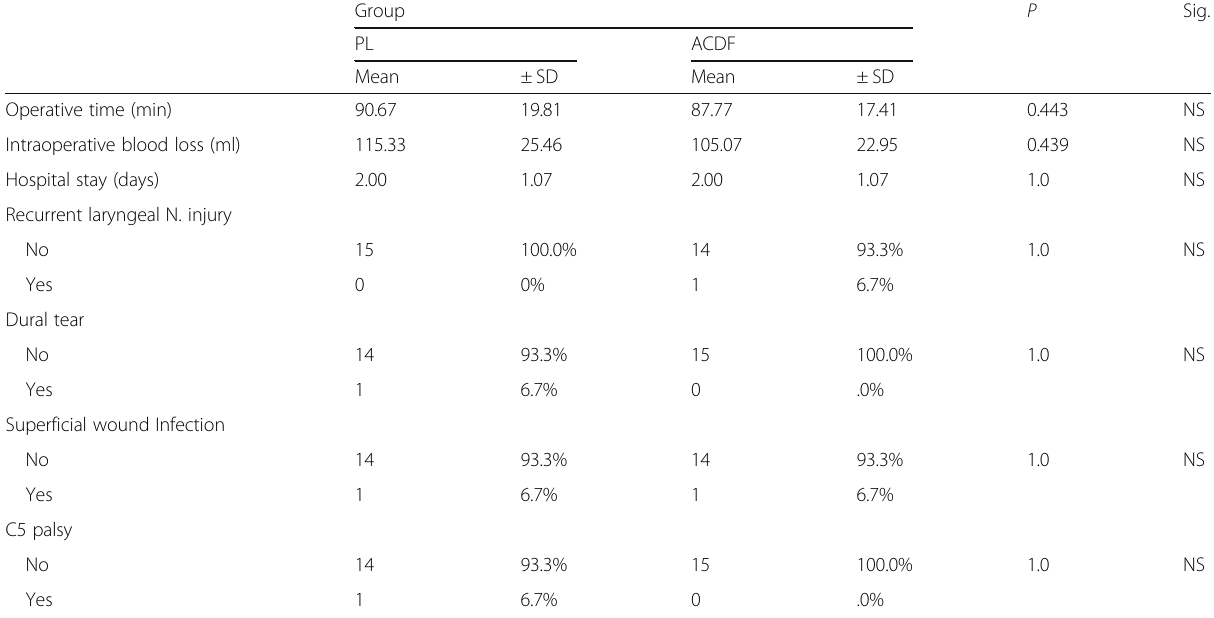
Table 8 Perioperative data and operative complications